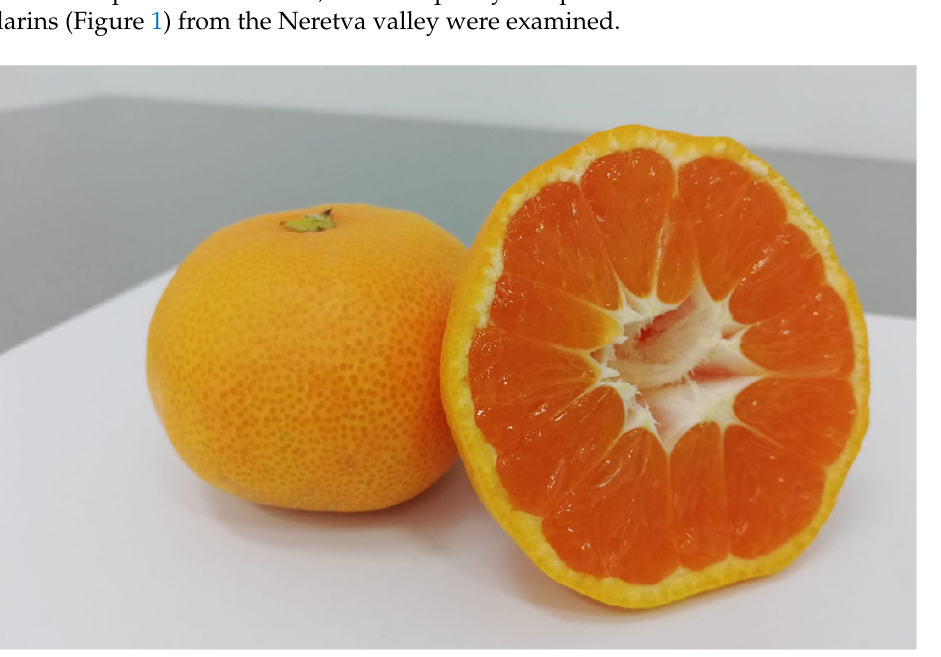
Figure 1. Sample of Satsuma mandarin (Chahara) from the experiment.